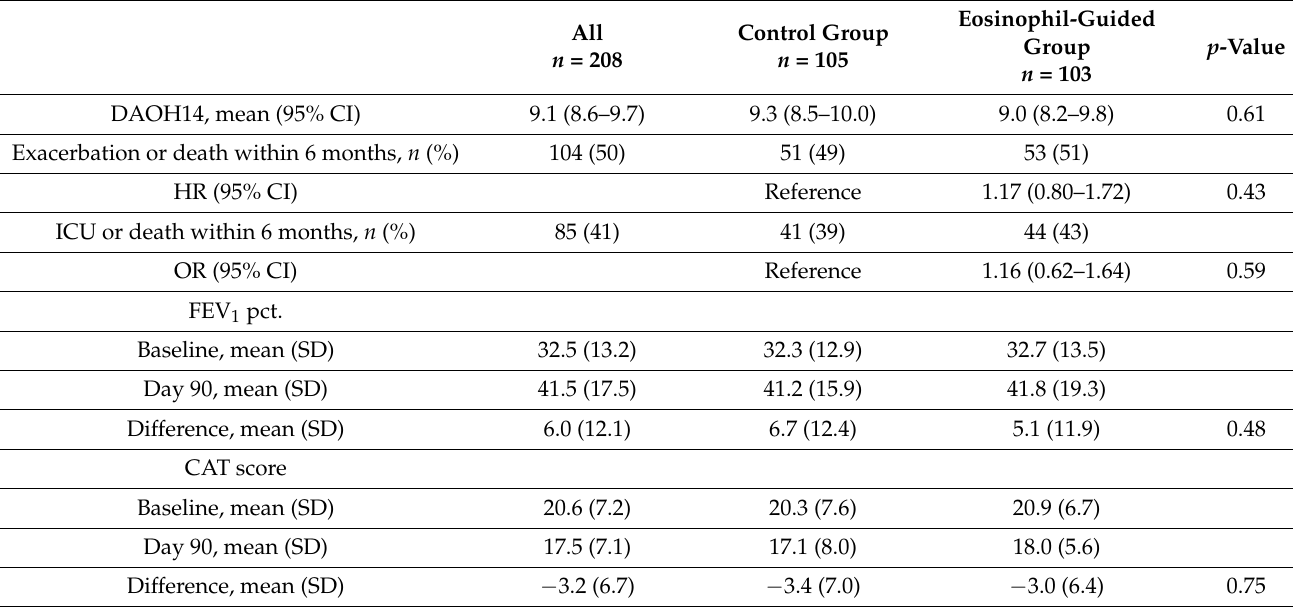
Table 3. Sensitivity analysis of ex-smokers.